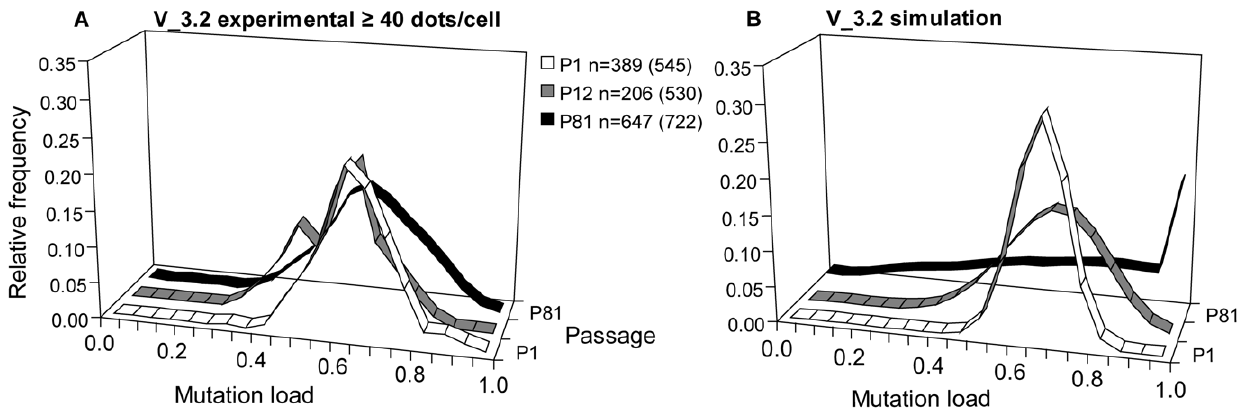
Figure 7. Cellular heteroplasmy evolution of V_50 P48 sub-clone V_3.2. (A) Relative m.3243A . G Padlock/RCA mutation load frequency histograms of cells in passages 1, 12 and 81 of sub-clone V_3.2. Histograms from cells with $ 60 dots/cell had similar shapes. Numbers in parentheses represent the total number of cells analyzed. (B) Relative mutation load frequency histograms of cells in passages 1, 12 and 81 of V_50 P42 sub-clone V_3.2 generated by computer simulation of random segregation (mtDNA copy number input 1,800/cell). Additional computer simulations showed that an mtDNA copy number input of 12,000 is required to explain the experimental distribution at P81 by random mtDNA segregation.